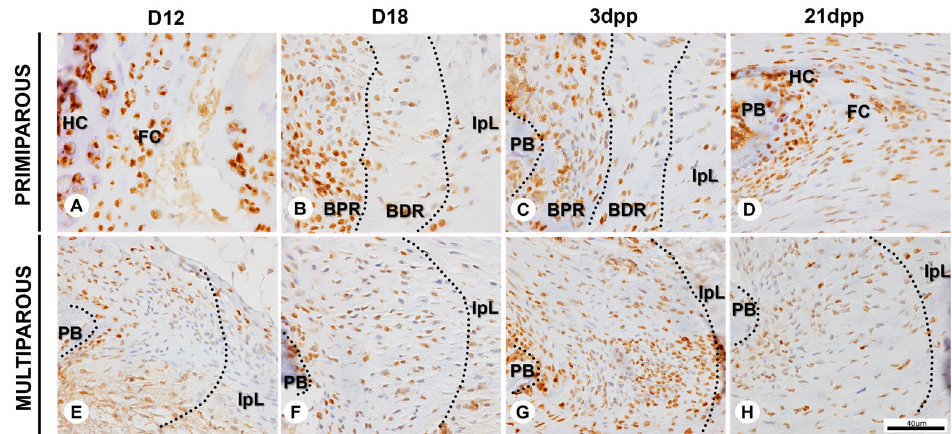
Figure 5. Immunopositive cells for Sox-9 at the symphyseal enthesis during pregnancy and post- partum in primiparous and multiparous senescent female mice. ( A – D ) Sox-9 immunostaining at hyaline cartilage (HC), fibrocartilage (FC), bone proximal region (BPR), bone distal region (BDR), and interpubic ligament (IpL). ( E – H ) Sox-9 immunostaining at the symphyseal enthesis and IpL. If distinguishable, demarcated areas with dotted lines correspond approximately to BPR and BDR.